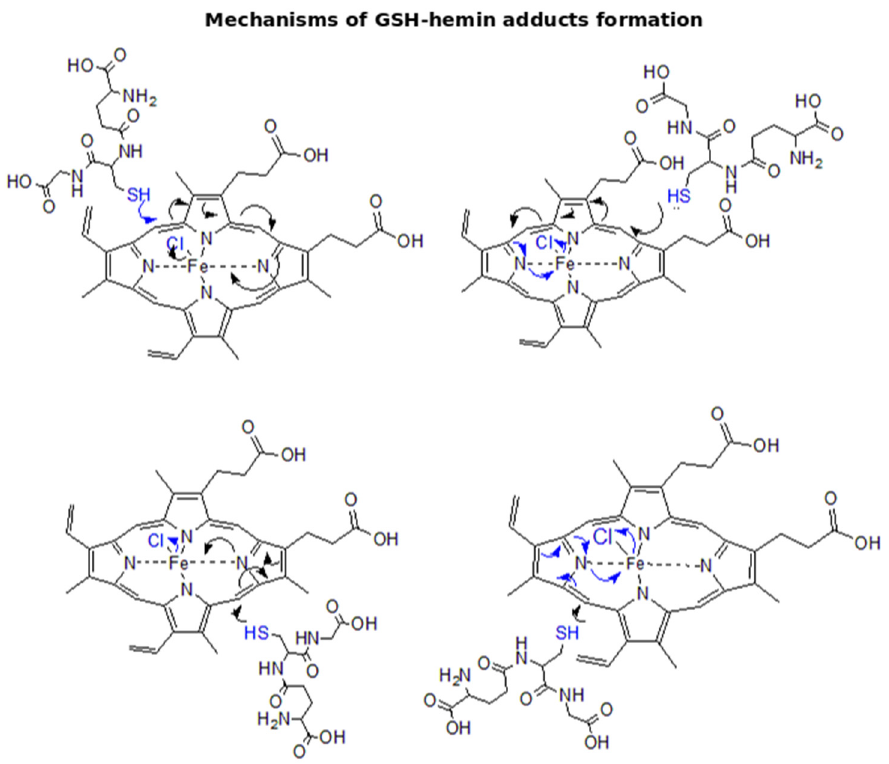
Figure 5. Proposed mechanisms of nucleophilic addition in the ethylene bridges of hemin by GSH yielding isomers of GSH–hemin adducts.